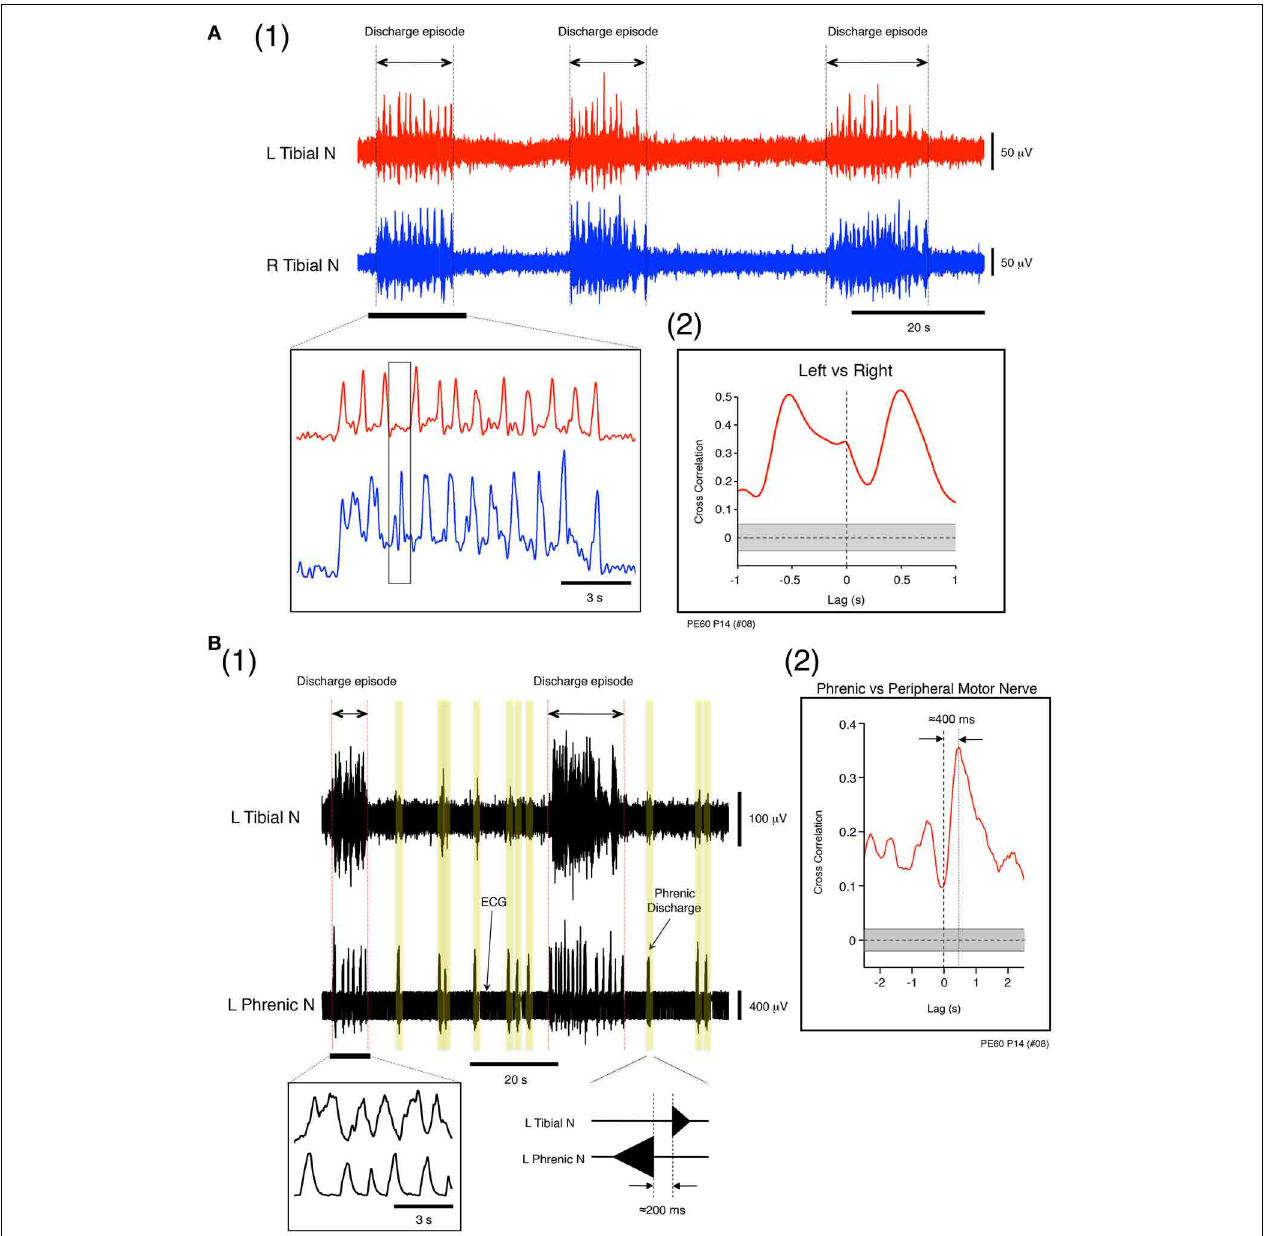
FIGURE 4 | (A) Left and right tibial nerve activity at a flow rate of 12 × TBV/min. (1) Recording showing the organization of neuronal activity into discharge episodes punctuated by quiescence. The results of rectification of the neuronal discharge episode appearing in the underlined part of the upper panel are shown in the left lower panel. The speed of the left and right alternating discharge was < 2Hz. (2) Recording showing correlation between instances of left and right tibial nerve discharge during discharge episodes. To determine the time lag between the two types of discharge during discharge episodes and the correlation in the time domain between lags from − 1 to 1s, time series data for the instances of left and right tibial nerve discharge during discharge episodes were obtained from the underlined data in the upper panel of (1) . In (2) , the left tibial nerve discharge positioned the right tibial nerve discharge to the right of vertical dotted line, and the right tibial nerve discharge positioned the left tibial nerve discharge to the left of the vertical dotted line. Each peak between the two gapped at ≈ 0 . 5s ( r = 0 . 5).